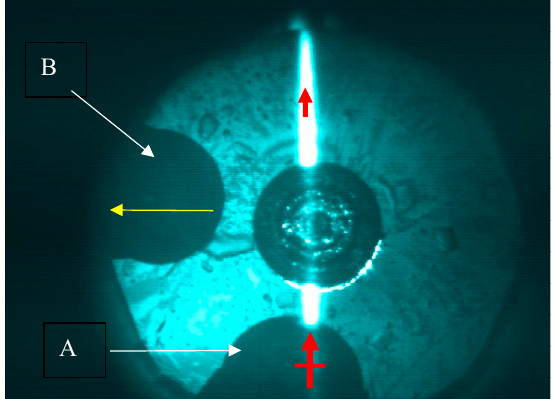
Figure 4. View of the X-ray beam entering and exiting the central, round fluid sample chamber in the lower diamond as seen through the unaltered upper diamond anvil. The entering X-ray beam (longer red arrow with a cross line to indicate polarization orientation, i.e., the electric vector). Diamond was removed from the lower anvil by laser ablation to form the two notches (A and B), to minimize attenuation of the X-rays as they pass through diamond, and is the reason that the beam itself does not cause fluorescence as it passes through notch A before it enters the fluorescent diamond anvil, where it appears white due to over exposure, and its less intense scattered blue fluorescence illuminates the anvil’s features. A very faint fluorescent line shows its course through the fluid sample in the circular recess in the center of the lower anvil face. The shorter red arrow shows the direct beam exiting the sample chamber, and the yellow arrow shows the very weak emitted beam directed to the detector, where its spectrum can be analyzed [7].